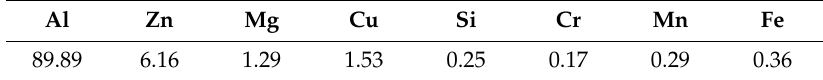
Table 1. Composition of 7075 Al alloy